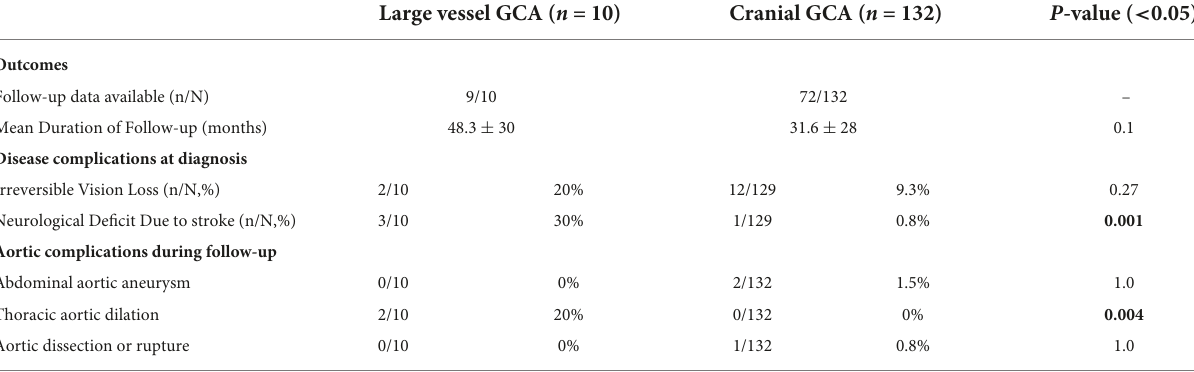
TABLE 3 Comparison of disease outcomes in patients with large vessel GCA (LV-GCA) and cranial GCA (C-GCA). Large vessel GCA ( n = 10) Cranial GCA ( n = 132) P -value ( <